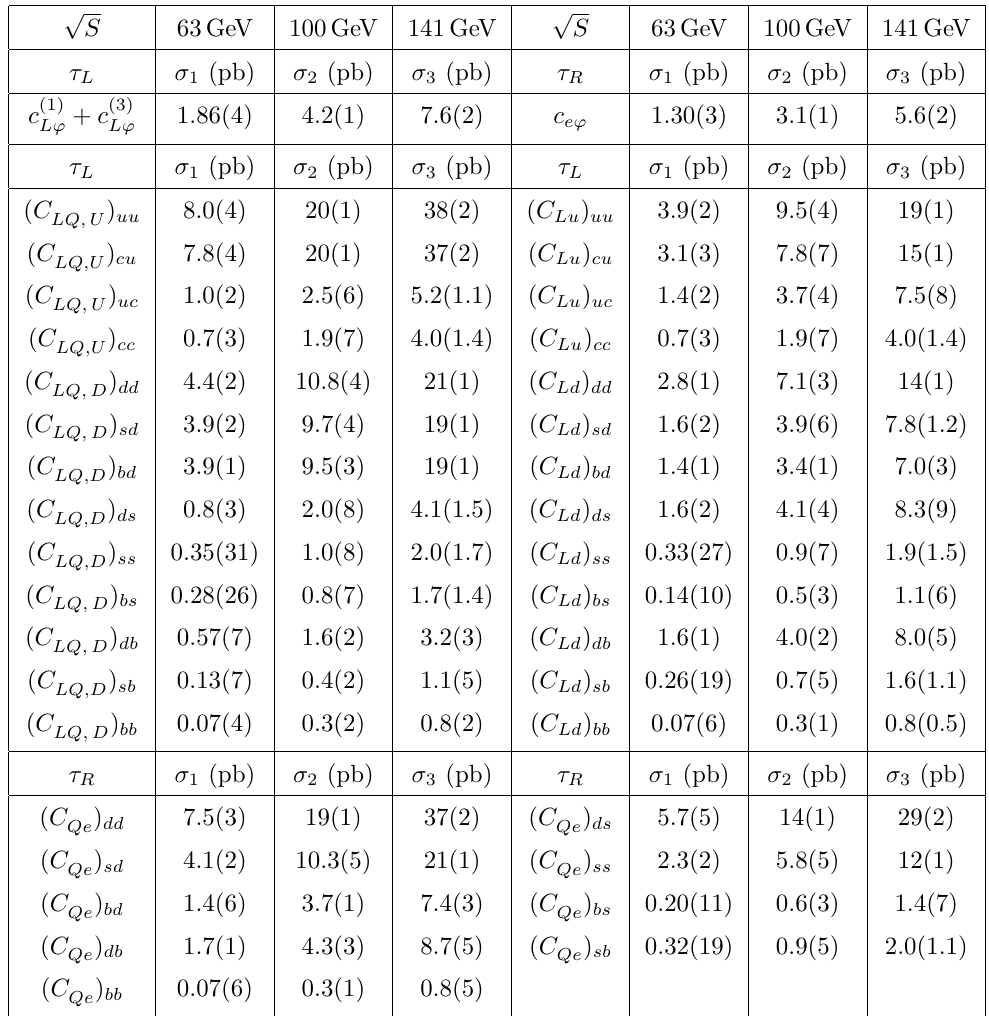
Table 1 . Numerical coefficients a iJ that control the cross sections σ i = a iJ | C J | 2 for the CLFV process ep → τX induced by CLFV Z couplings, vector and axial four-fermion operators. The subscript i = { 1 , 2 , 3 } denotes each of the three benchmark points discussed in the text, at 63 , 100 , 141 GeV, respectively, while J is the operator label. Here we omit interference terms between Z couplings and four-fermion operators. The labels τ L,R denote the polarization of the τ lepton emitted by the effective operators. The cross section is computed with the NNPDF31_lo_as_0118 PDF set [54]. The error estimates includes PDF and scale uncertainties. Terms quadratic in C